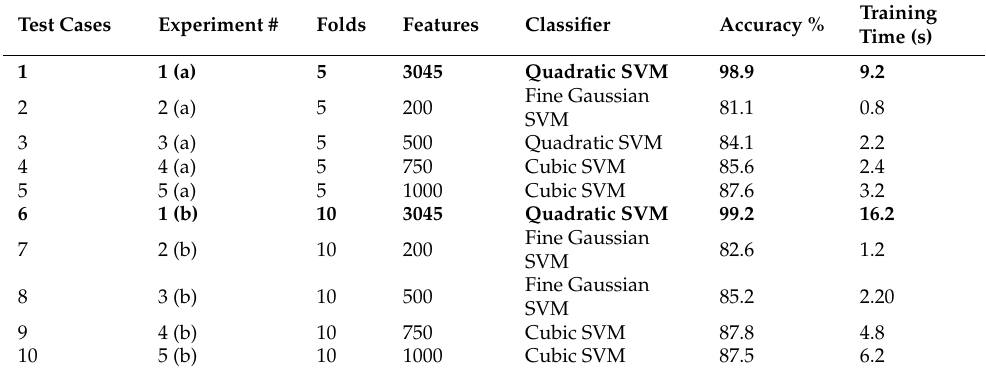
Table 3. Summary of